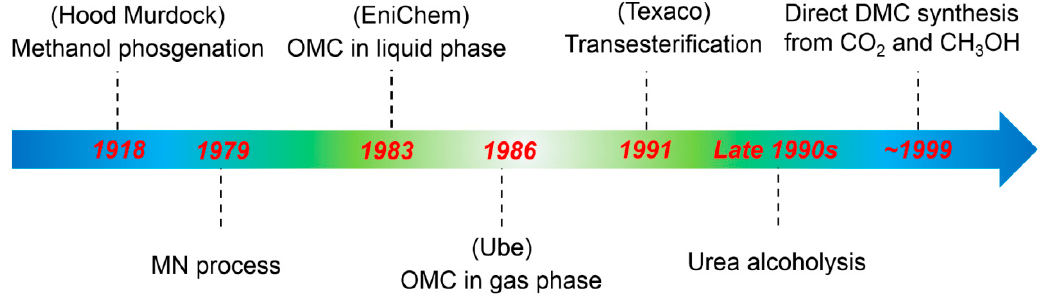
Figure 1. Evolution of DMC synthesis.